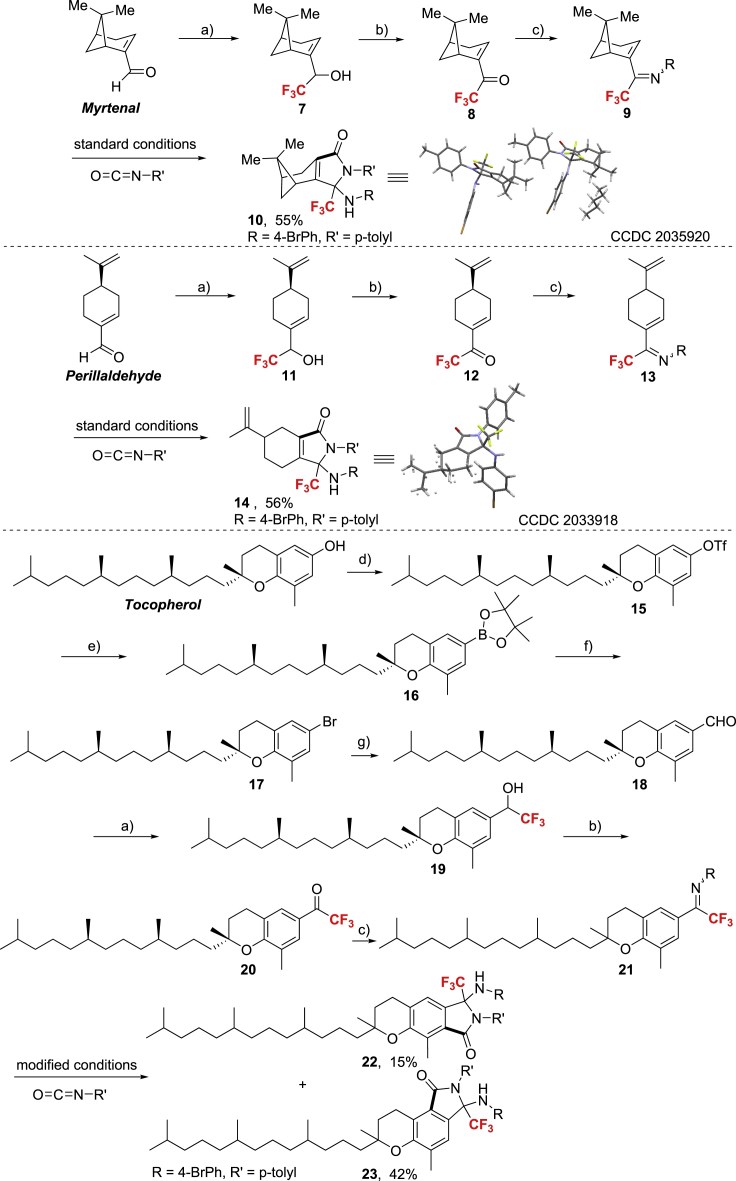
Derivation of Complex MoleculesReaction conditions: (a) TMSCF3 (2.2 equiv.), TBAF (0.5 equiv.), in THF under Ar, -40 °C to rt; (b) DMP (1.2 equiv.), in DCM, rt for 30 min; (c) 4-Br-aniline (2.0 equiv.), TsOH⋅H2O (0.2 equiv.), in toluene, at 140 °C for 48 h; (d) Tf2O (1.3 equiv.), Et3N (2.5 equiv.), in DCM, at 0 °C for 30 min; (e) B2pin2 (2.0 equiv.), PdCl2(dppf) (10 mol%), Et3N (3.0 equiv.), in dioxane, at 100 °C for 4 h; (f) CuBr2 (3.0 equiv.), in MeOH, at 90 °C for 72 h; (g) n-BuLi (2.0 equiv.), DMF (5.0 equiv.) in THF, at -78°C.